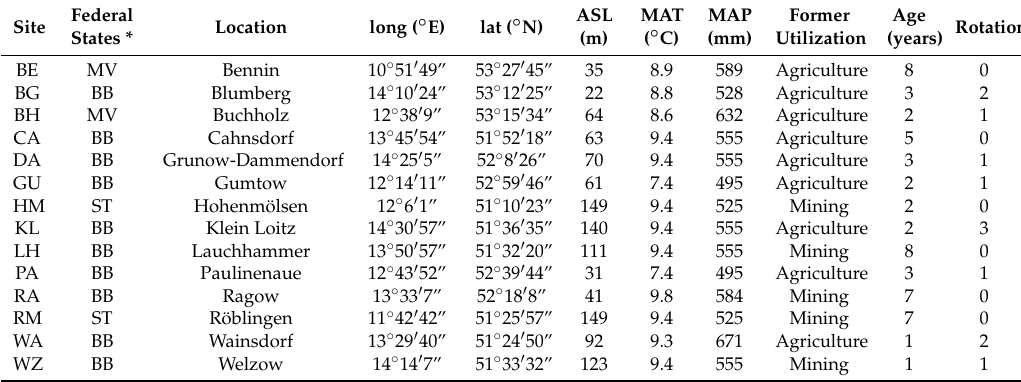
Table 1. Site description including federal states, location, longitude (long), latitude (lat), elevation above sea level (ASL), mean annual temperature (MAT), mean annual precipitation (MAP), former utilization, age, and rotation.